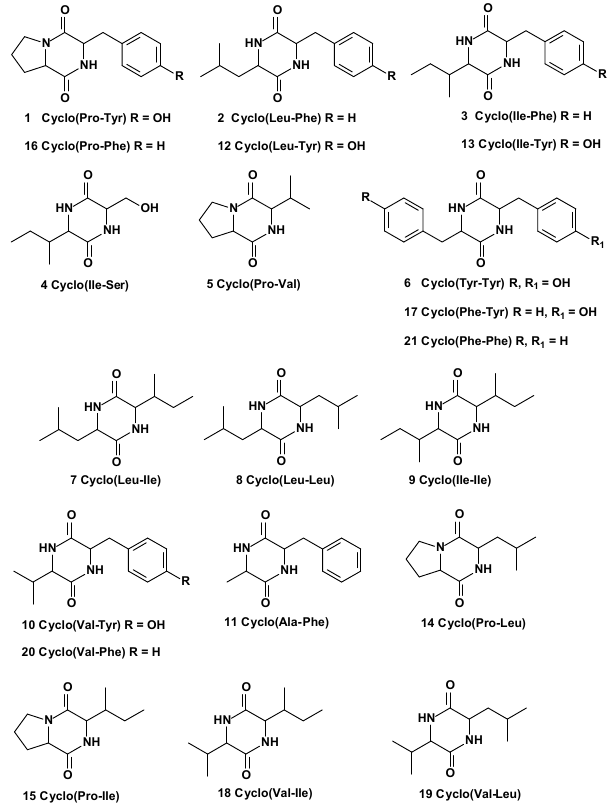
Figure 2. Structural isomers of diketopiperazines detected in acellular culture supernatant residues from X. fastidiosa 9a5c grown in XFM medium.